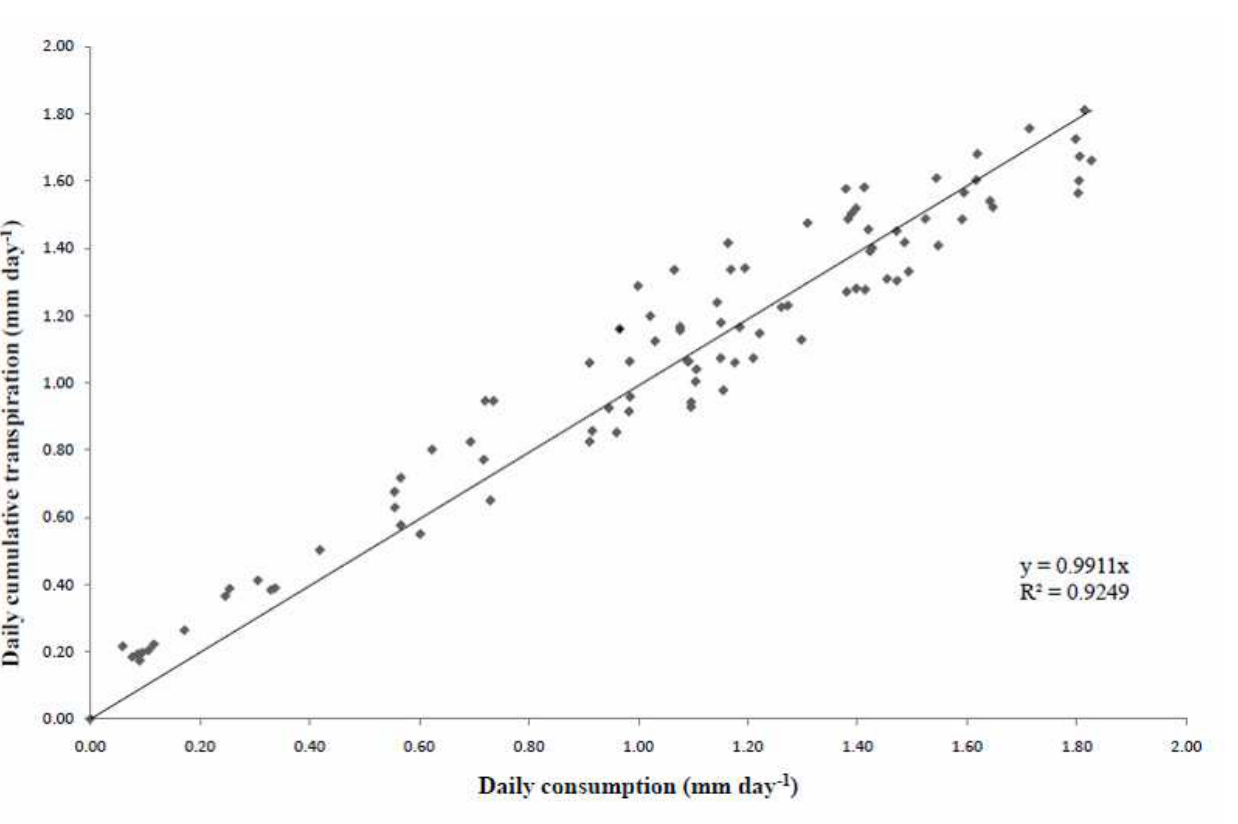
Figure 7. Testing the values of transpiration measured with daily consumption data in an autumn–winter cycle. It represents the daily accumulated transpiration and the daily average of the five trays with twelve plants consumption